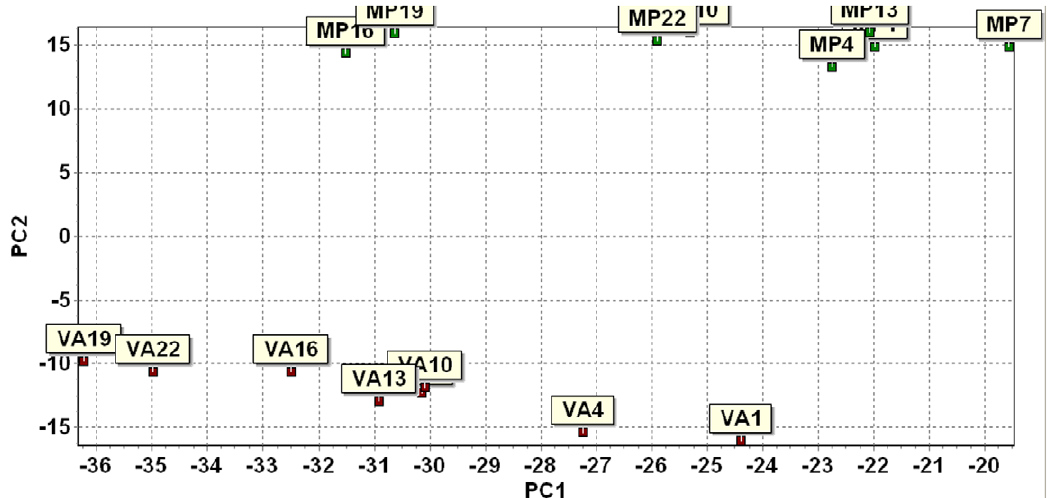
Figure 3. Plot showing the grouping of Mp313E and Va35 samples in the qRT-PCR study by principal component analysis. Notice the Mp313E and Va35 samples were grouped into two distinct groups. It indicated the criteria used for candidate gene selection from the microarray data were effective in reflecting host plant specific responses to the fungal infection.